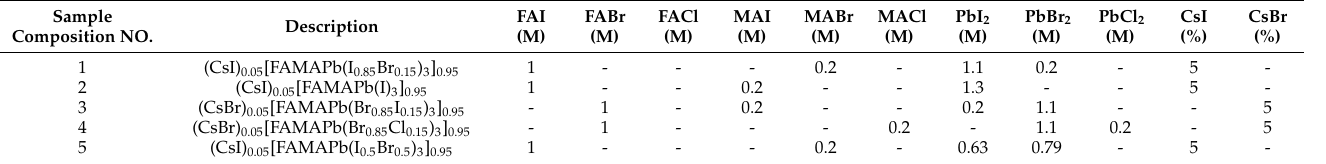
Table 1. Compositions of materials used to prepare triple-cation perovskite precursors. The molar ratio of each chemical is shown for each